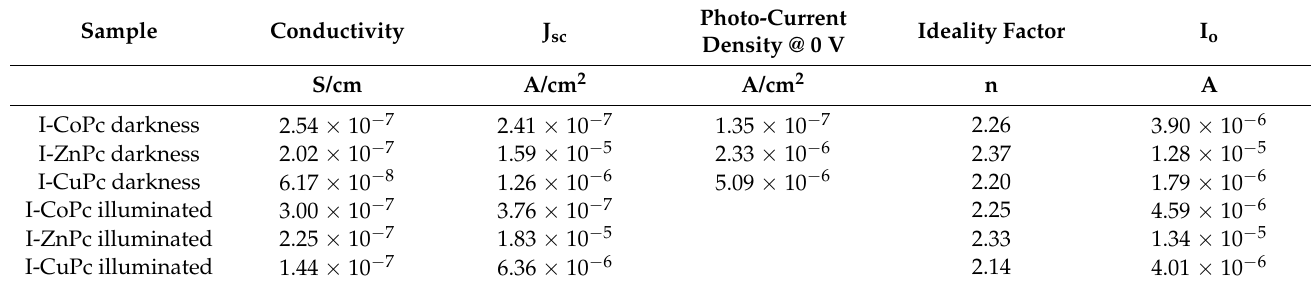
Table 2. Electrical properties of doped MPcs (M = Co, Zn, Cu) for darkness and illuminated